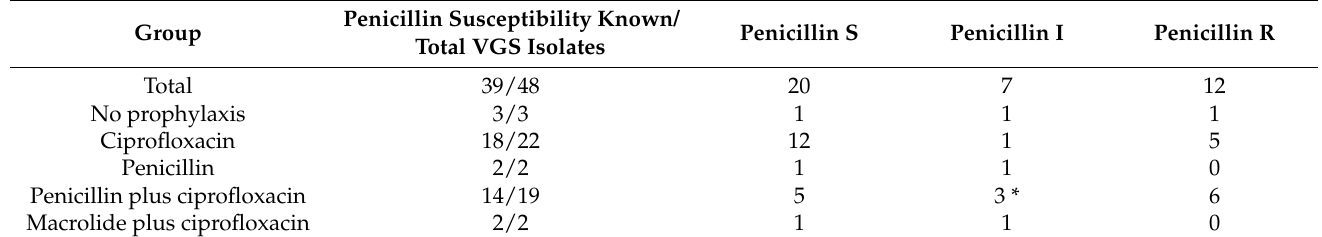
Table 5. Penicillin susceptibility of viridans group streptococci isolates and per antibacterial prophy- laxis